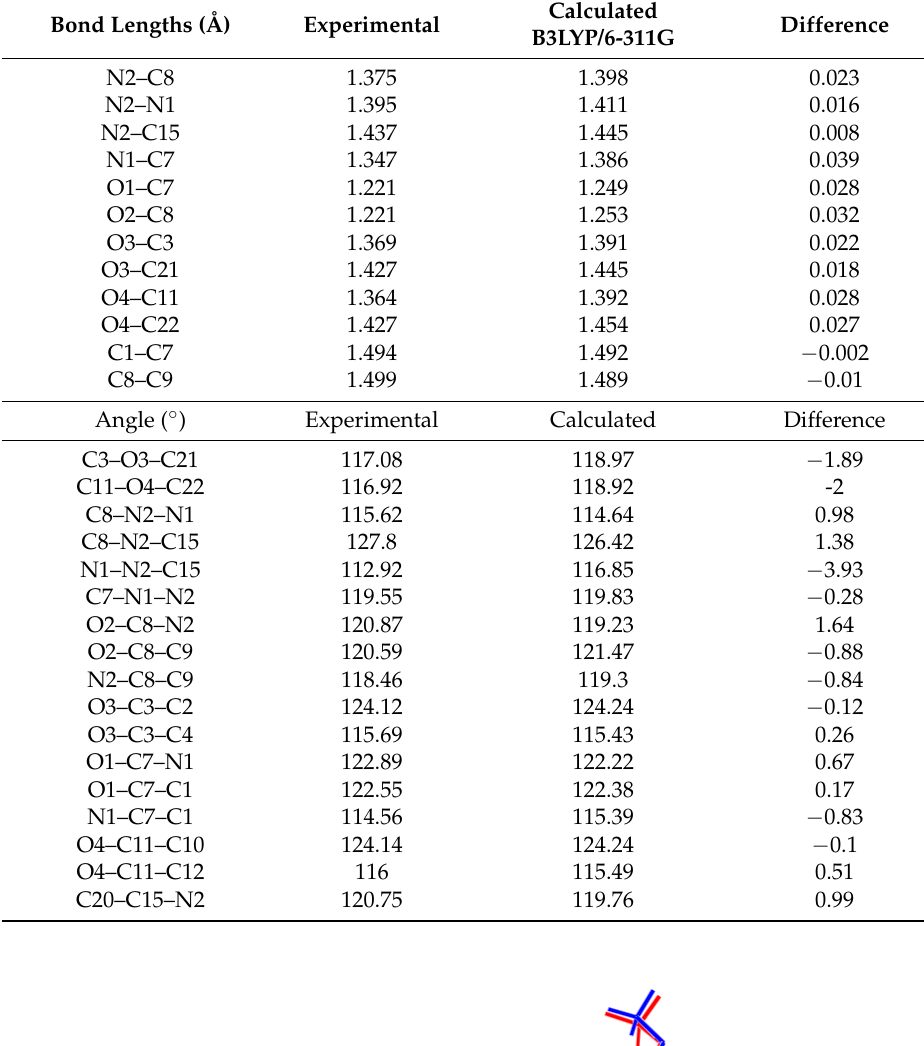
Table 2. Experimental and theoretical selected geometric parameters of 1 (Å, ◦ ).